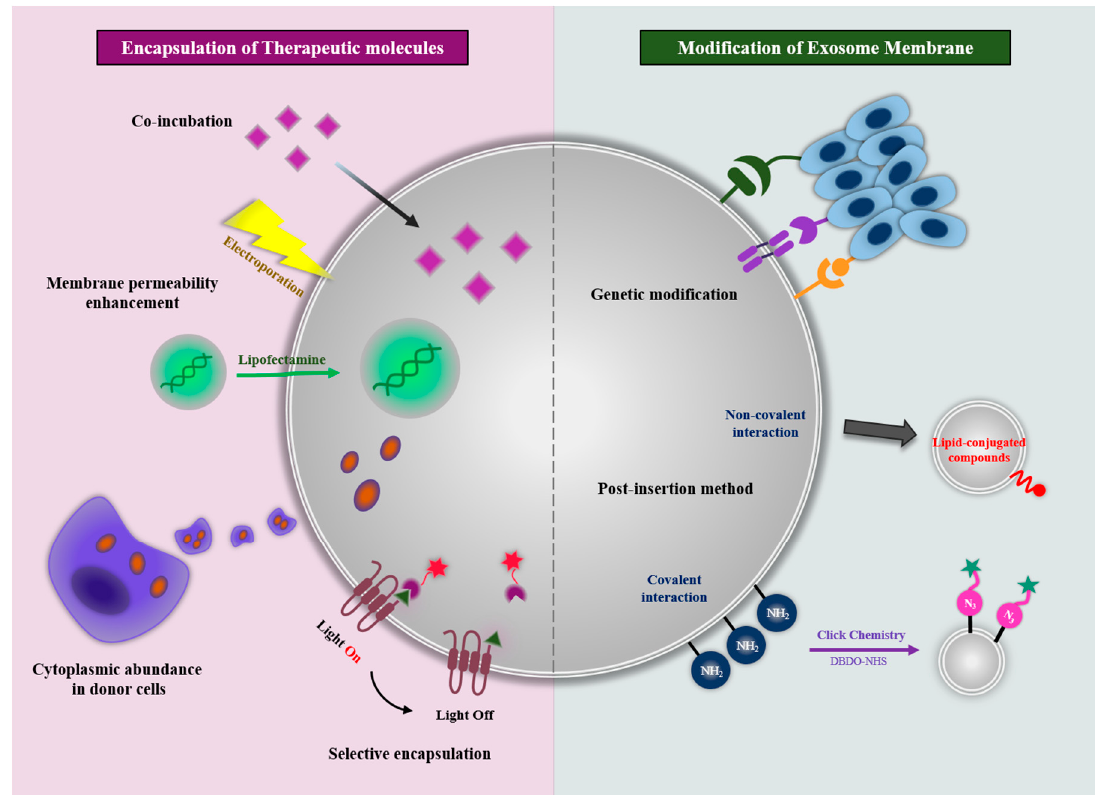
Figure 3. Engineering methods of exosomes as a nanoplatform for improving therapeutic efficacy. Exosomes could be therapeutically engineered with the encapsulation of therapeutic molecules and modification of the exosome membrane. Encapsulation methods involve co-incubation (direct mixing), membrane permeability enhancement (physical/chemical stimuli), cytoplasmic abundance in donor cells, and selective encapsulation via machinery related with exosome biogenesis and release. Membrane modification methods involve genetic modification and the post-insertion